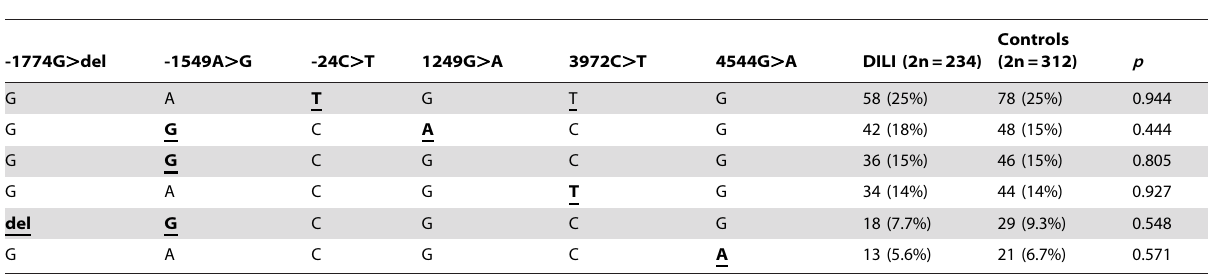
Table 3. Predicted haplotype frequencies of transporter gene polymorphisms.